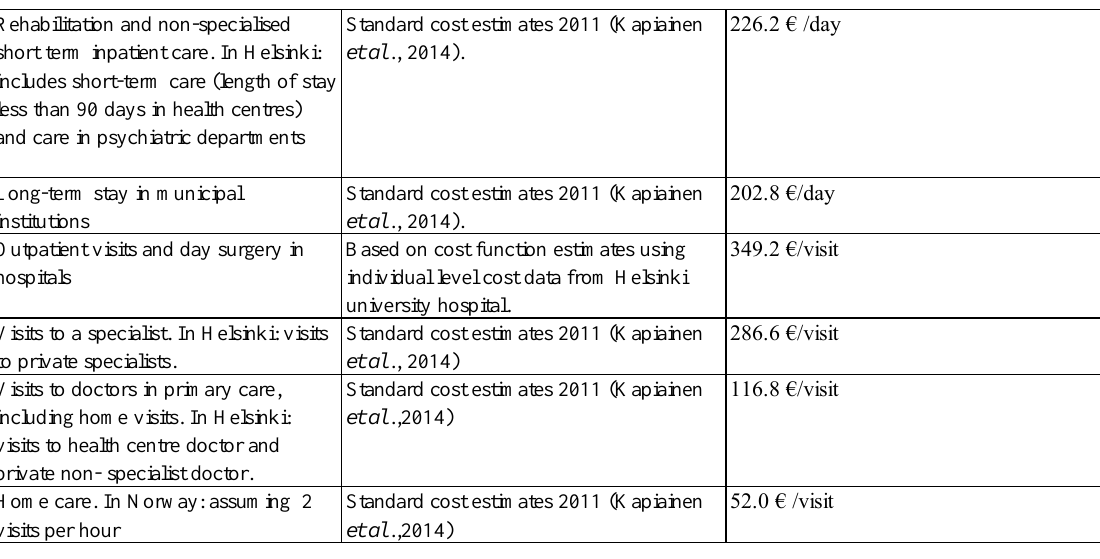
Table A2: Definition of additional services and their costing in capital